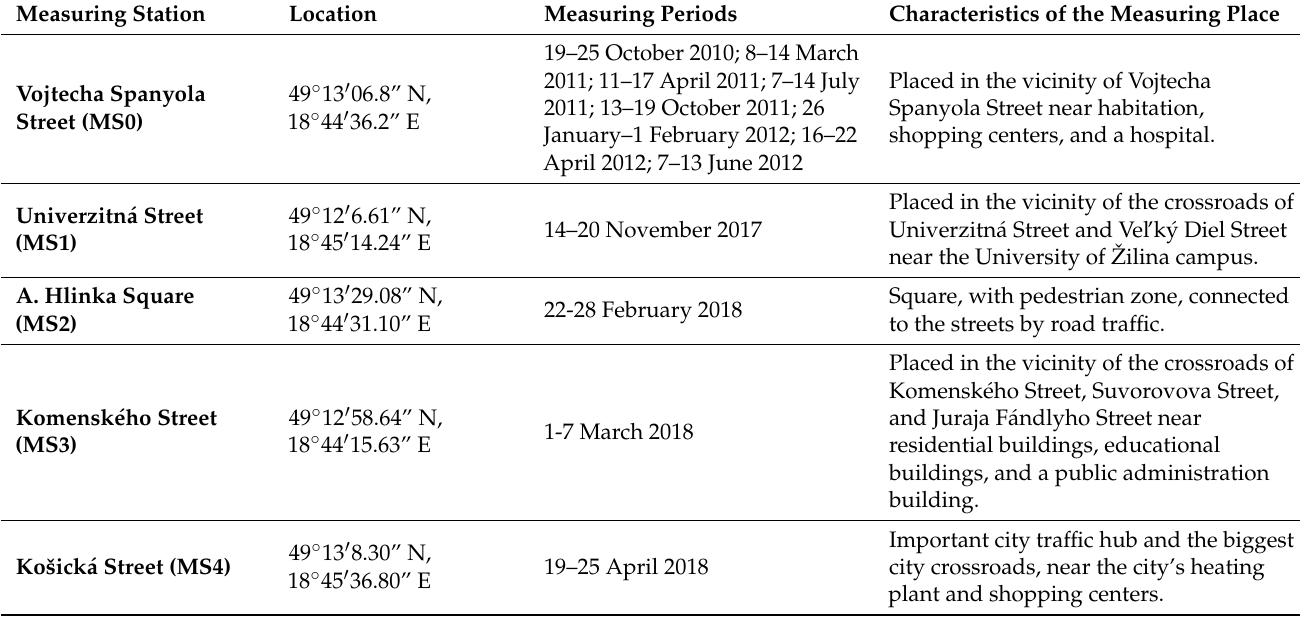
Figure 1. Location of measurement stations in Žilina, Slovakia (Source: https://ismcs.cdb.sk/portal/mapviewer/, accessed on 26 July 2021). Table 2. PM measuring stations in the city of Žilina, Slovakia.